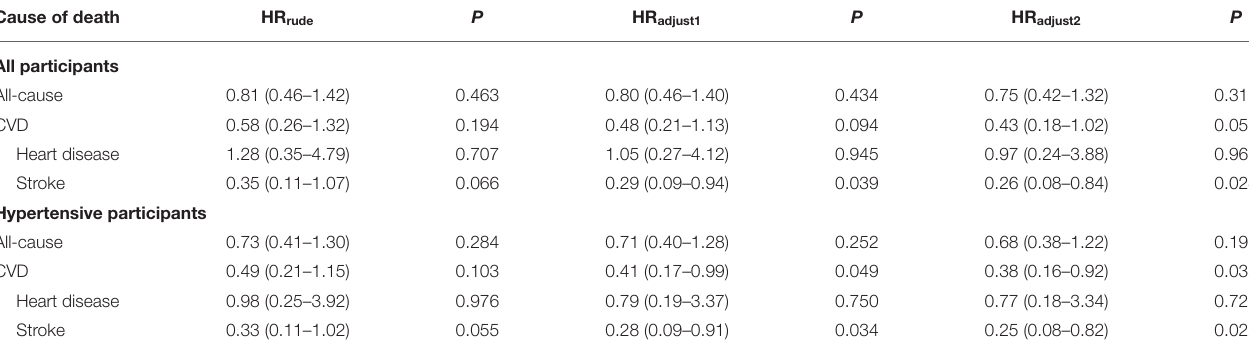
TABLE 3 | Effect of salt substitute intervention on all-cause mortality and cardiovascular disease mortality among all and hypertensive participants. Cause of death HR rude P HR adjust1 P HR adjust2 P